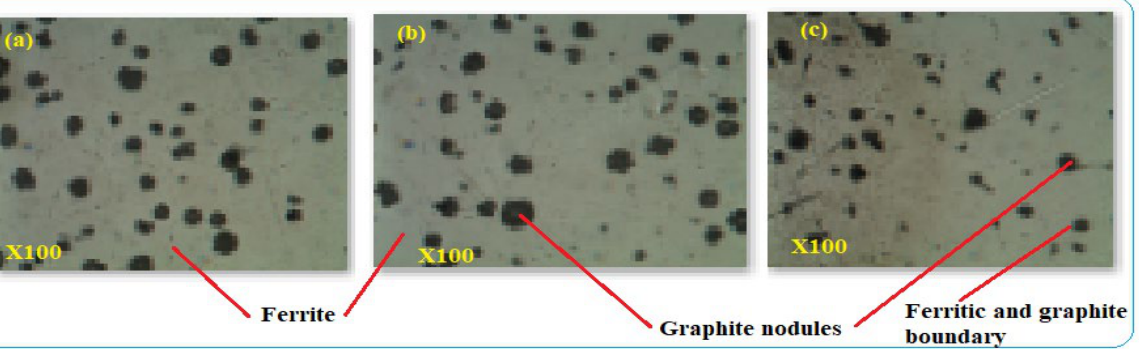
Figure 7. ( a – c ) Microstructures of DIP pipe.